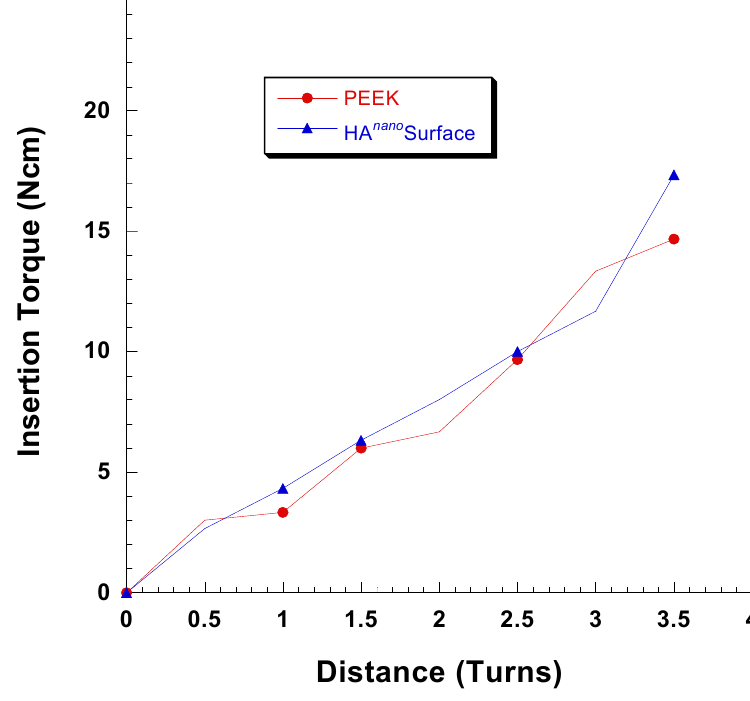
Figure 1. Insertion torque vs. distance for the coated and uncoated implants. The implant was inserted with its top at the level of the surrounding bone surface at 3.5